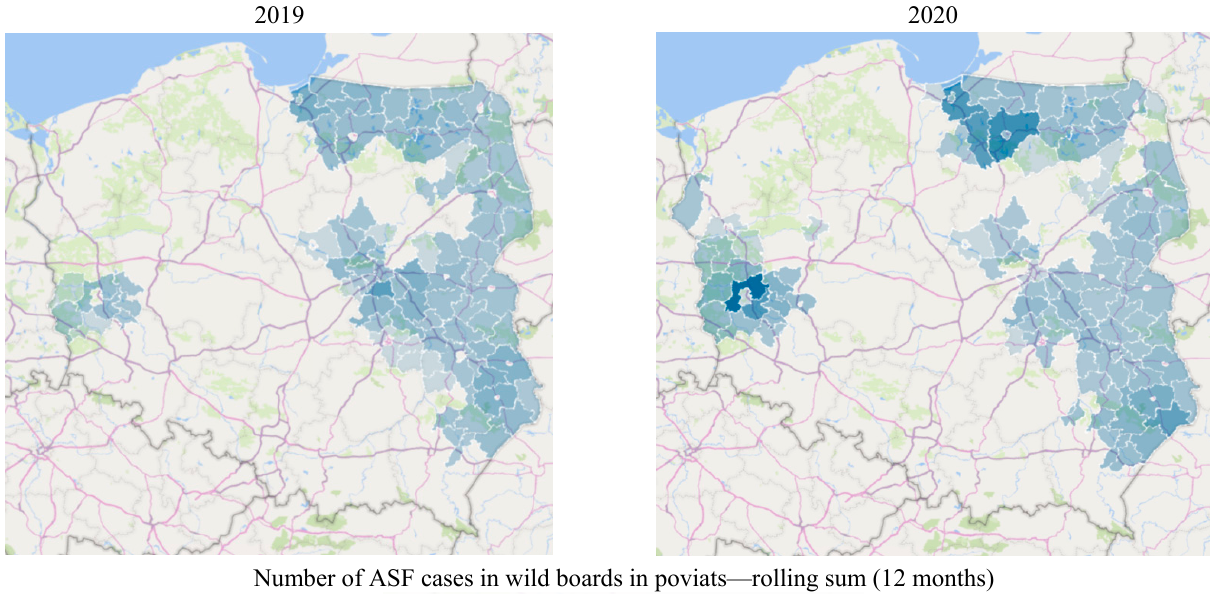
Scheme 1. ASF movement in Poland in 2019–2020—the number of ASF cases in wild boars